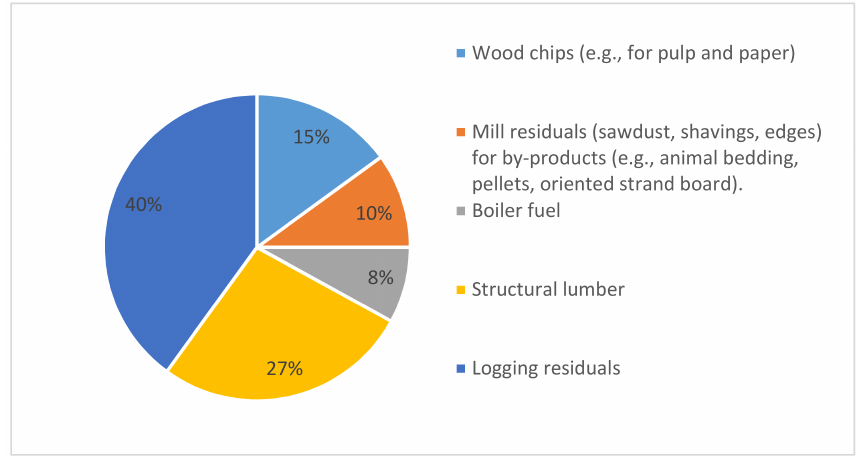
Figure 2. Tree biomass (Douglas fir) division upon harvest